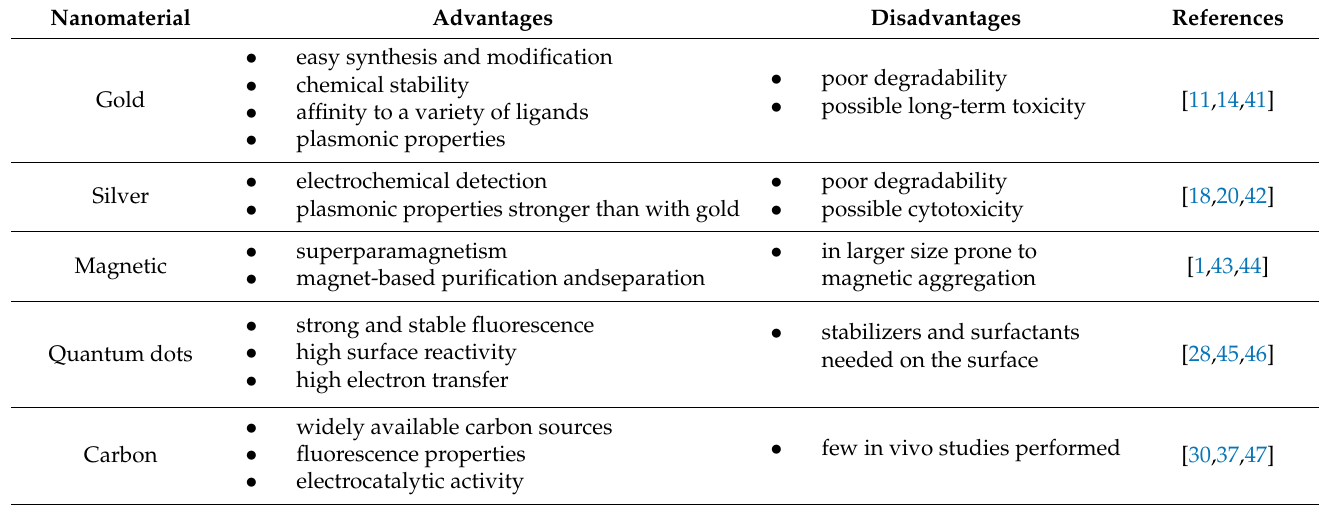
Table 1. Types of nanomaterials used as substrates for miRNA